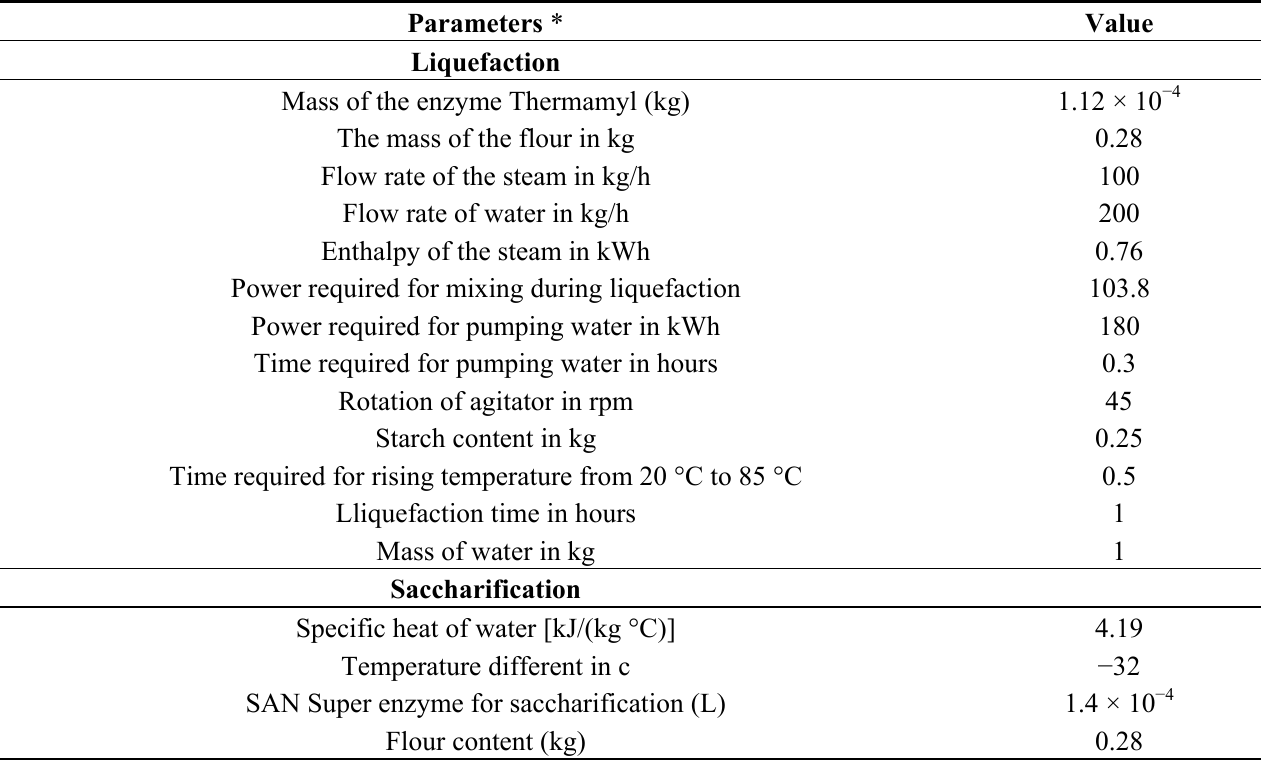
Table A3. Parameters used in the life cycle analysis at the third stage (ethanol